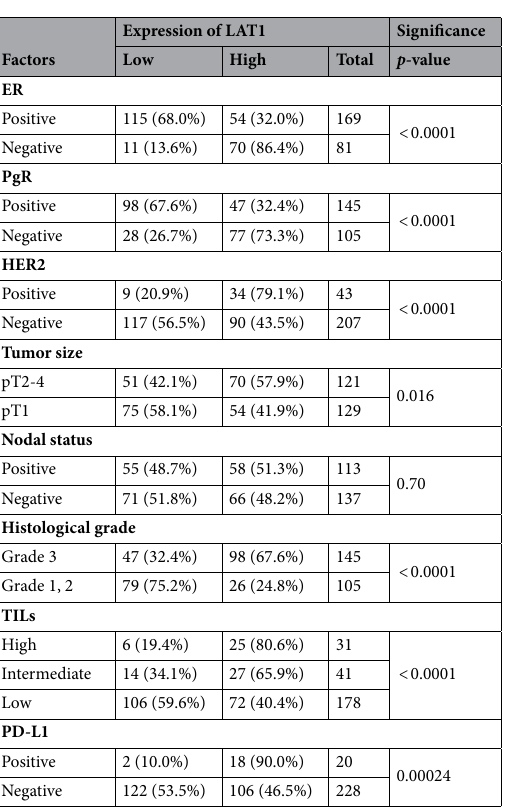
Table 1. Association of LAT1 expression with clinicopathological factors in all patients. LAT1 L-type amino acid transporter 1, ER estrogen receptor, PgR progesterone receptor, HER2 human epidermal growth factor receptor 2, TIL tumor-infiltrating